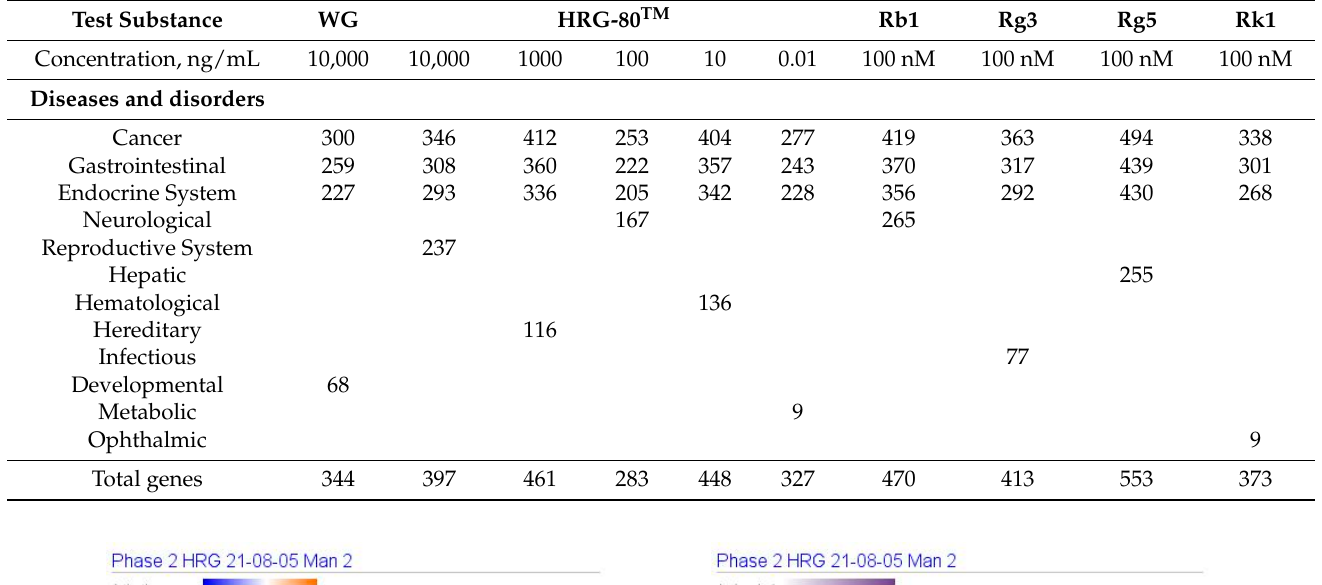
Table 2. The number of genes associated with various diseases and deregulated by ginseng extracts HRG80 TM and WG, and ginsenosides Rb1, Rg3, Rg5.